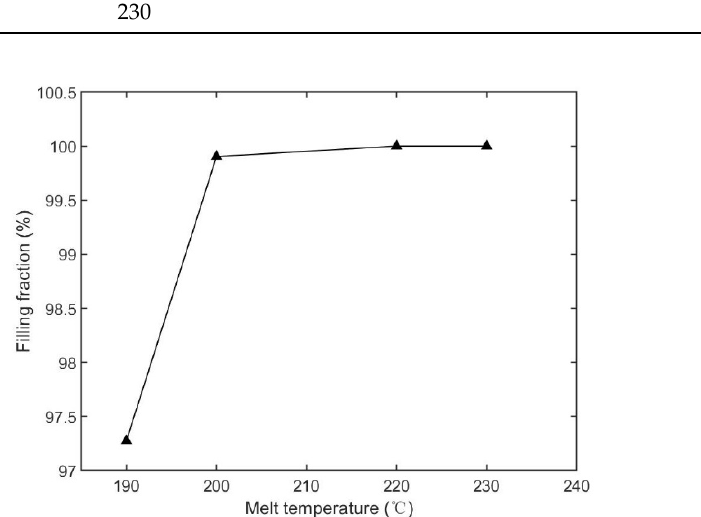
Figure 5. Relationship between the melt temperature and filling fraction, based on Table 4. The filling contours at the end of filling, for each case, are shown in Figure 6. The base portion was fully filled for all cases. The microneedle portions in the 190 °C and 200 °C cases were not filled well. The filled fraction of the central microneedle was the worst in both the 190 °C and 200 °C cases. The microneedle array was almost filled in the 200 °C case.